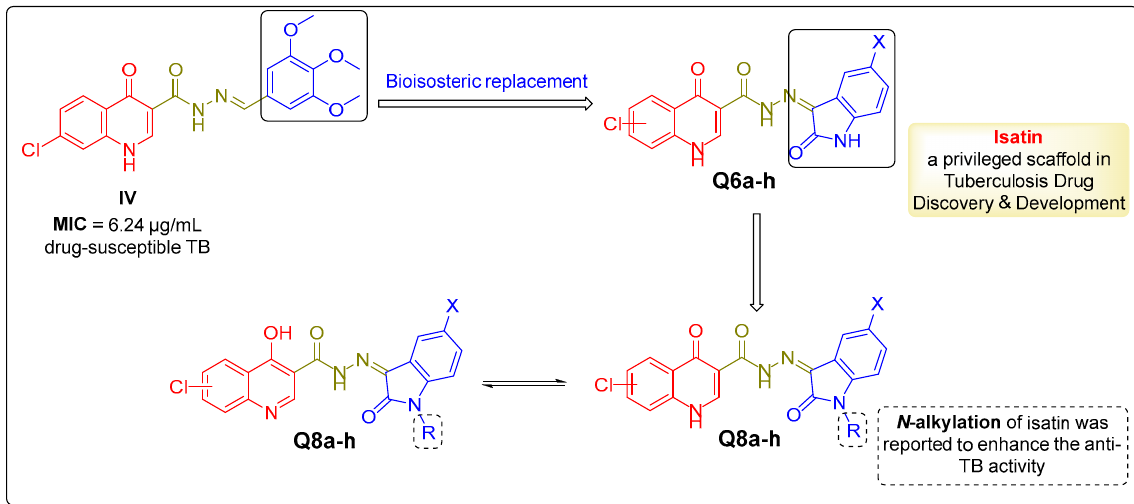
Figure 2. Design for the target quinoline-based molecules Q6a – h and Q8a – h .